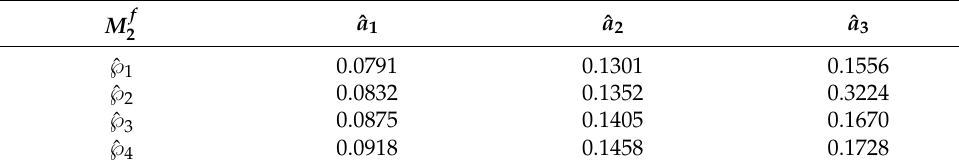
with entries in terms of fuzzy values. 2